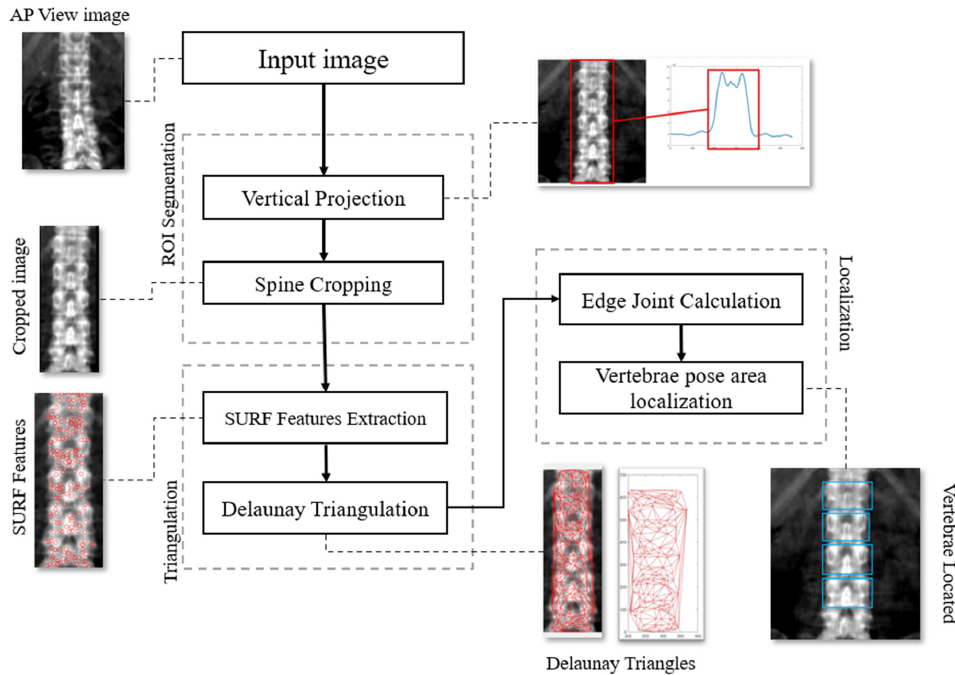
Figure 5. Outline of proposed framework .